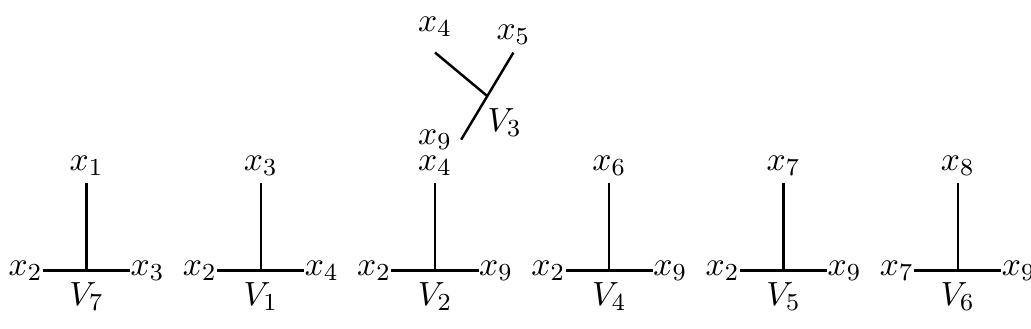
Figure 6 . A possible flow diagram for a 9-point asymmetrical